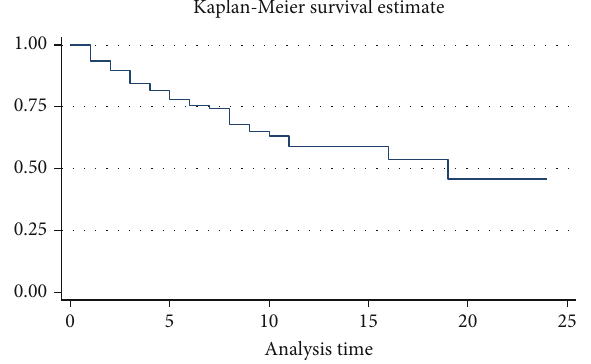
Figure 1: Overall Kaplan-Meier survivor function.